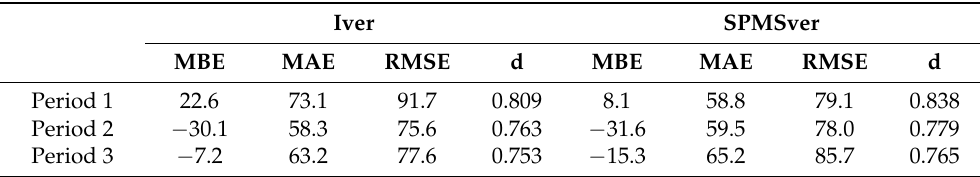
Table 2. Median values of MBE, MAE, RMSE and d for the Iver and SPMSver and the three meteorological periods regarding wind direction. Iver SPMSver MBE MAE RMSE